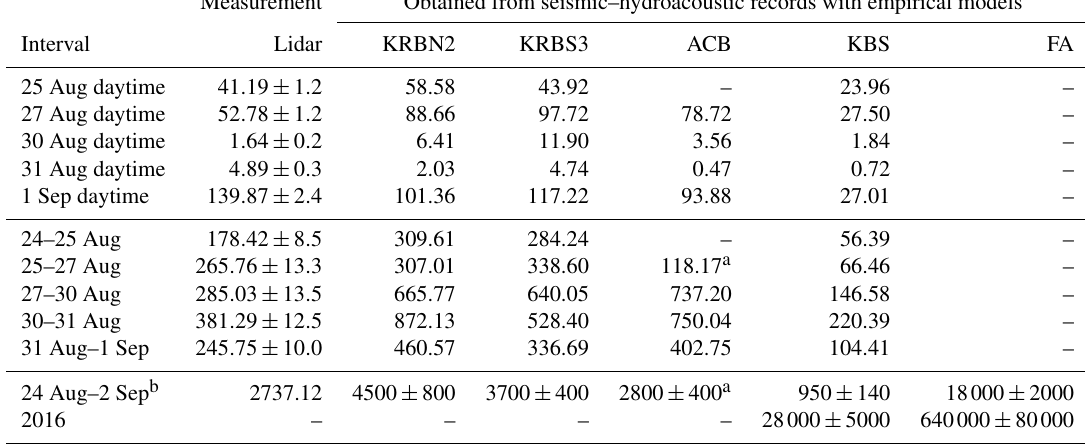
Table 1. Cumulative dynamic ice loss modeled and measured (lidar) for different time intervals in units of thousands of cubic meters. Only calving signals originating in the scanned range of terminus are used. FA: frontal ablation (including submarine calving and melt) obtained from Köhler et al.